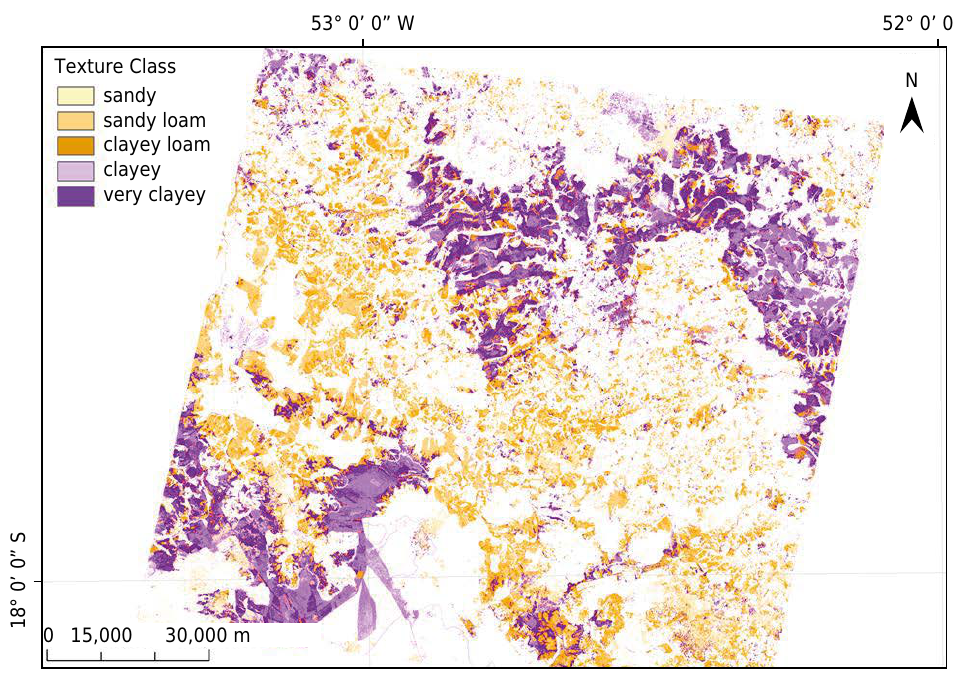
Figure 7. Map of texture classes of Area